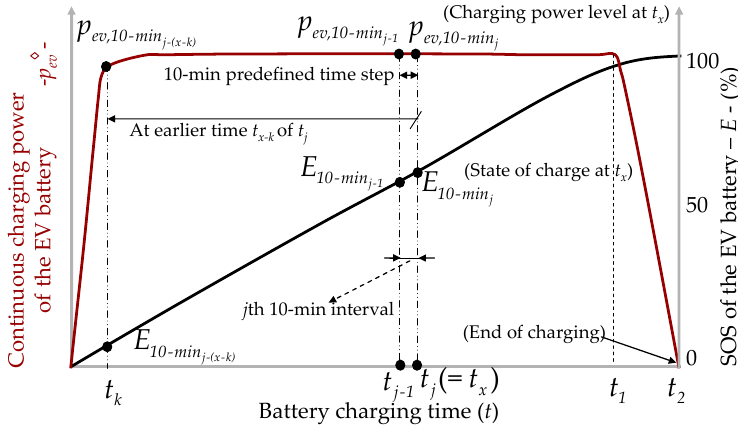
Figure 1. Charging profile and SOC of lithium-ion batteries.